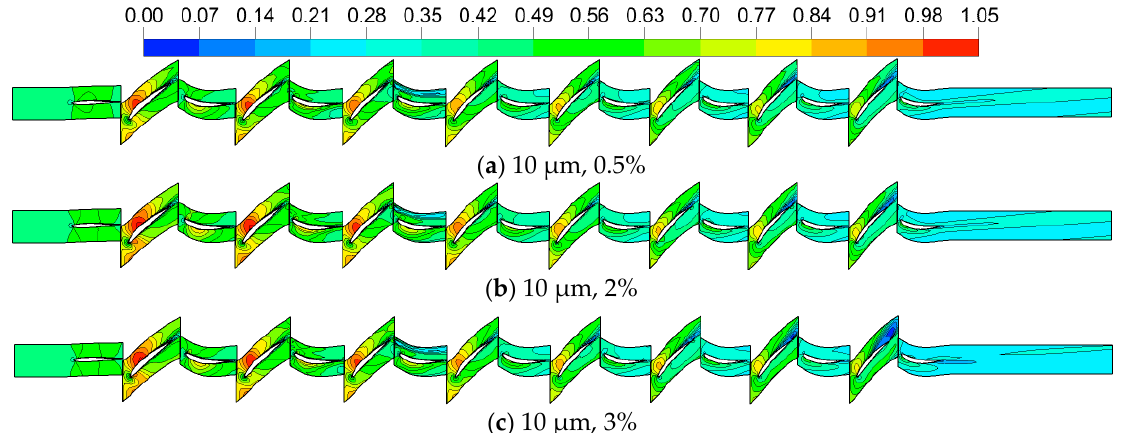
Figure 22. Mach Number contours of 50% span on the blade to blade surface under water of different injecting rate.